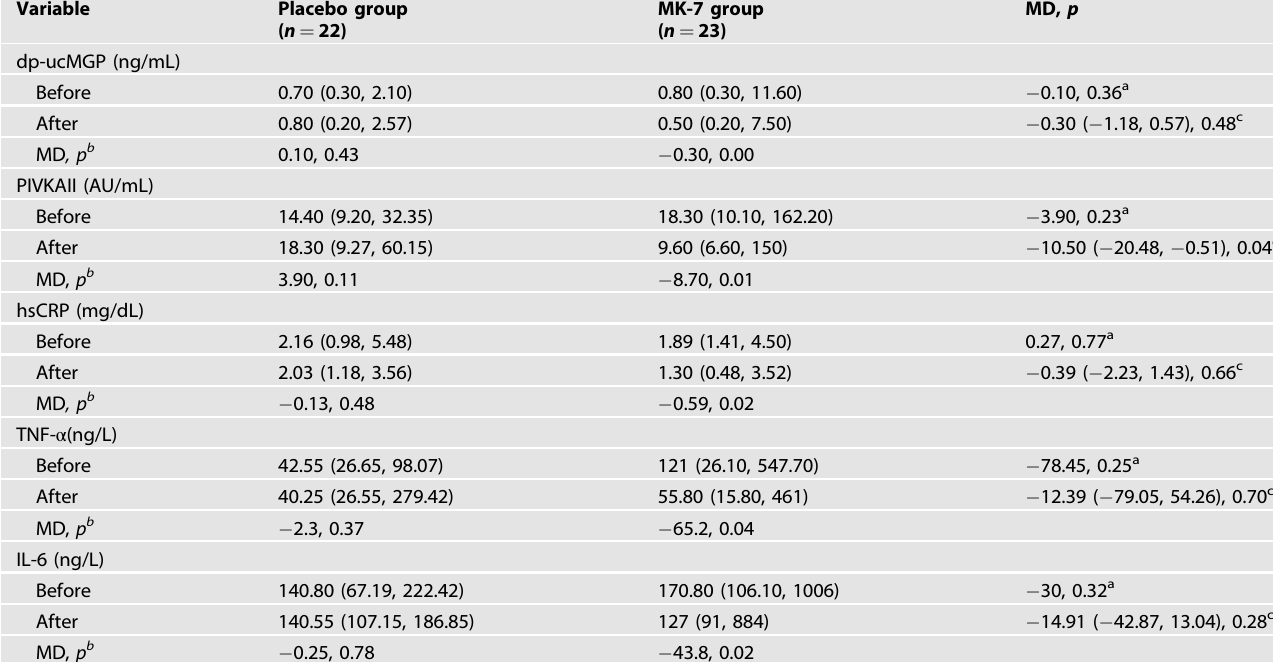
Table 4. Comparison of vitamin K status and in fl ammatory markers between study groups at baseline and at the end of the intervention. Variable Placebo group